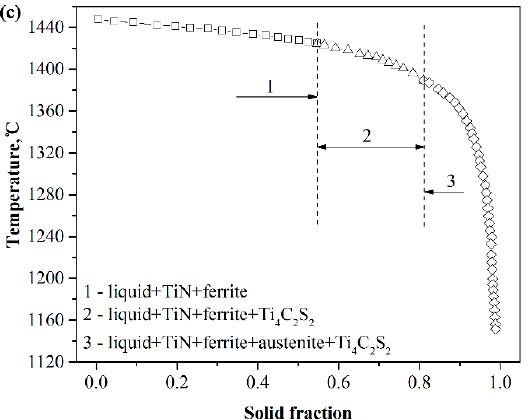
Figure 14. Scheil solidification calculation result for 20Cr-8Ni stainless steel: ( a ) S1; ( b ) S2; and ( c )